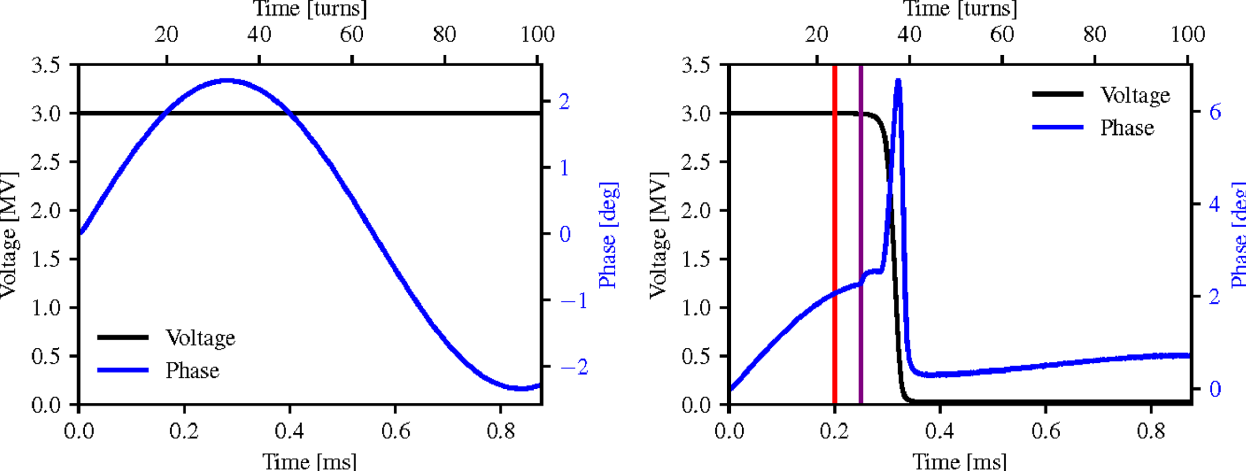
FIG. 17. Crab cavity voltage and phase as a function of time for the SPS, both NoFail (left) and Fail (right) as defined in Sec. V C. For the Fail scenario, the first vertical line (red) marks the beginning of the quench, and the second line (purple) the time when pressure detuning becomes